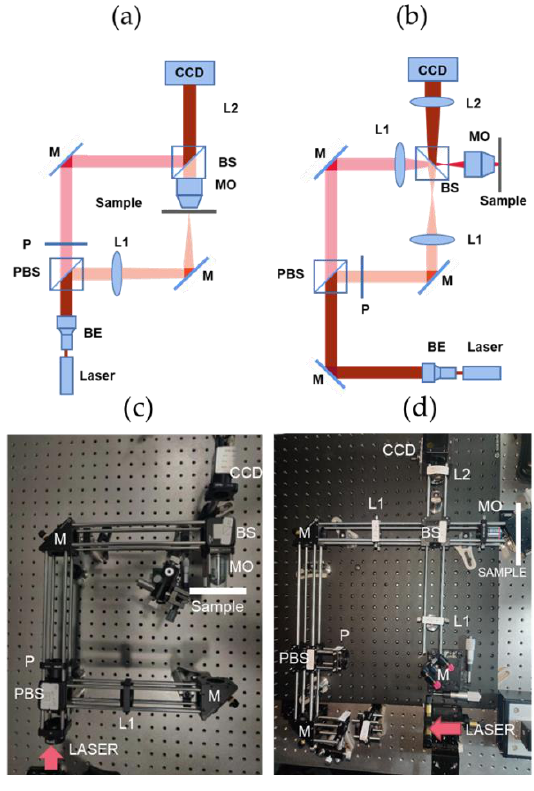
Figure 2. Schematic diagrams of DHM. ( a ) Transmission DHM. ( b ) Reflection DHM. The experiment setups of ( a ) and ( b ) are illustrated in ( c , d ), respectively. M: mirror, L1, L2: condenser, PBS: polarization beam splitter, BS: beam splitter, P: half-wave plate, MO: microscope objective, BE: beam expander.